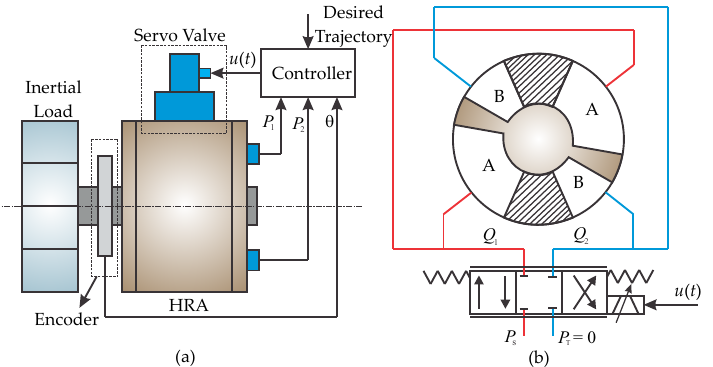
Figure 1. The studied electro-hydraulic system configuration. ( a ) The architecture of the EHS control system; ( b ) The hydraulic circuit of the considered